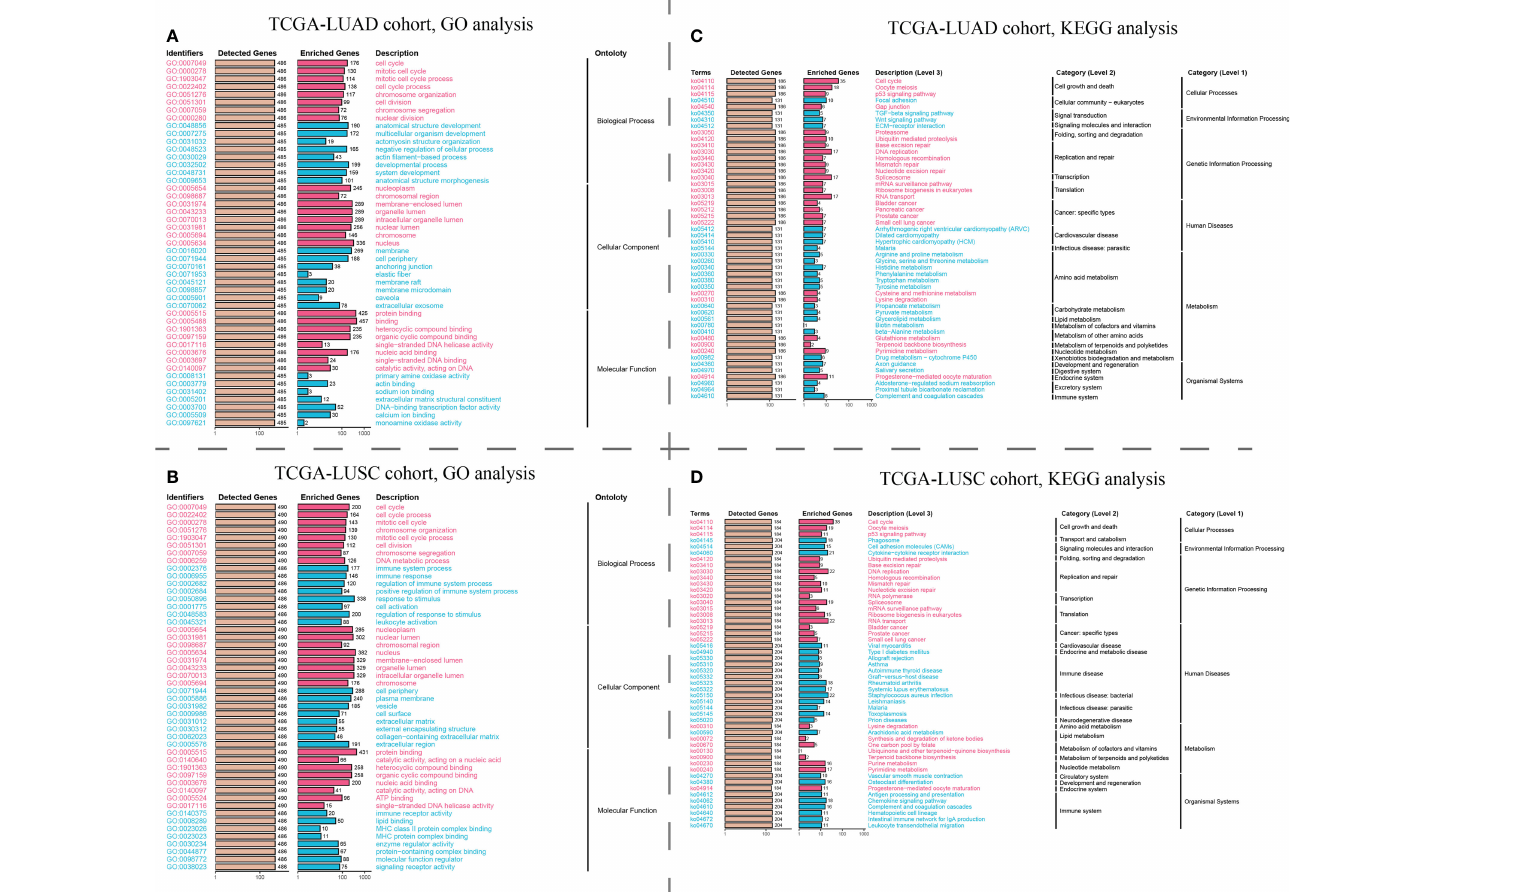
FIGURE 8 Pathway enrichment analysis of the hub ZWINT gene by GO and KEGG in LUAD and LUSU. (A, B) GO and KEGG analysis for investigating the relationship between the classic cancer pathways and the hub ZWINT gene in LUAD. (C, D) GO and KEGG analysis for evaluating the relationship between the classic cancer pathway and the hub ZWINT gene in